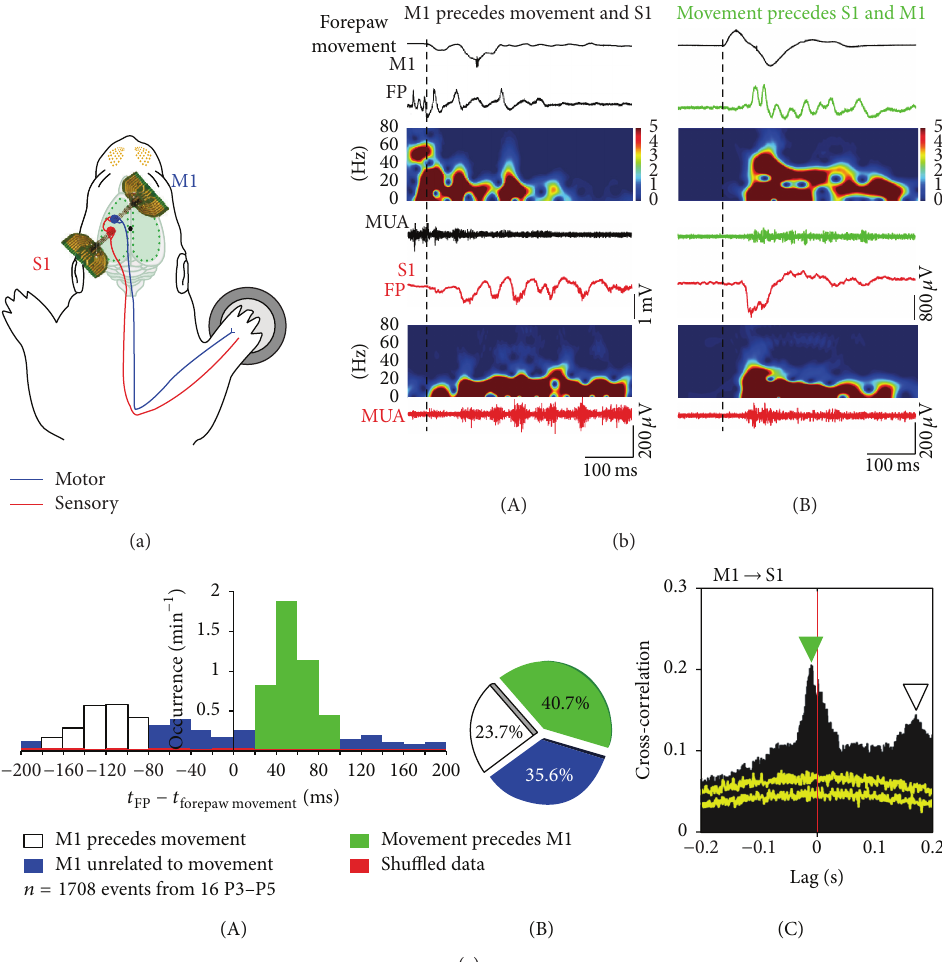
Figure 5: Movement-correlated synchrony of spontaneous network activity in S1 and primary motor cortex (M1) in newborn rat in vivo. (a) Schematic illustration of the experimental setup with multielectrode arrays in S1 (red) and M1 (blue). Piezo element attached to the contralateral forepaw monitors movements. Blue line indicates the motor pathway and red line the sensory pathway. (b) Relationship between forepaw movements and cortical activity in S1 and M1 in a P4 rat. (A) Spontaneous activity in M1 (black) elicited forepaw movement and preceded spindle burst in S1 (red). Black dashed line indicates time point of forepaw movement. Top black trace shows forepaw movement. (B) Spontaneous forepaw movement preceded activity in M1 (green) and spindle burst in S1 (red). (c) Relationship between spontaneous activity in M1 and S1 and forepaw movements. (A) Bar diagram illustrating the occurrence of FP activity, which preceded forepaw movements (blank box), followed forepaw movements (green), and were unrelated to movement (blue) in 16 P3–P5 rats. Red bars represent results from the shuffled dataset. (B) Pie diagram showing the percentages of the three patterns (1708 events from 16 P3–P5 rats during 10 min unstimulated recordings). (C) Cross-correlation of MUA between S1 and M1. Note that S1 MUA precedes M1 MUA (green arrowhead) and M1 MUA precedes S1 MUA (blank arrowhead). Yellow traces represent results from the shuffled dataset. Reproduced with permission from